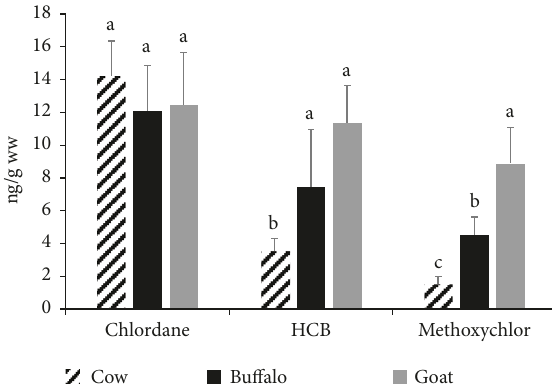
Figure 7: Chlordane, HCB, and methoxychlor residues in the examined milk samples. Data represent mean ± SE (ng/g ww) for chlordane, HCB, and methoxychlor residues in the examined milk samples from different animal species (n=20 each). Columns that carry same superscript letter among the same chemical are not significantly different at p <